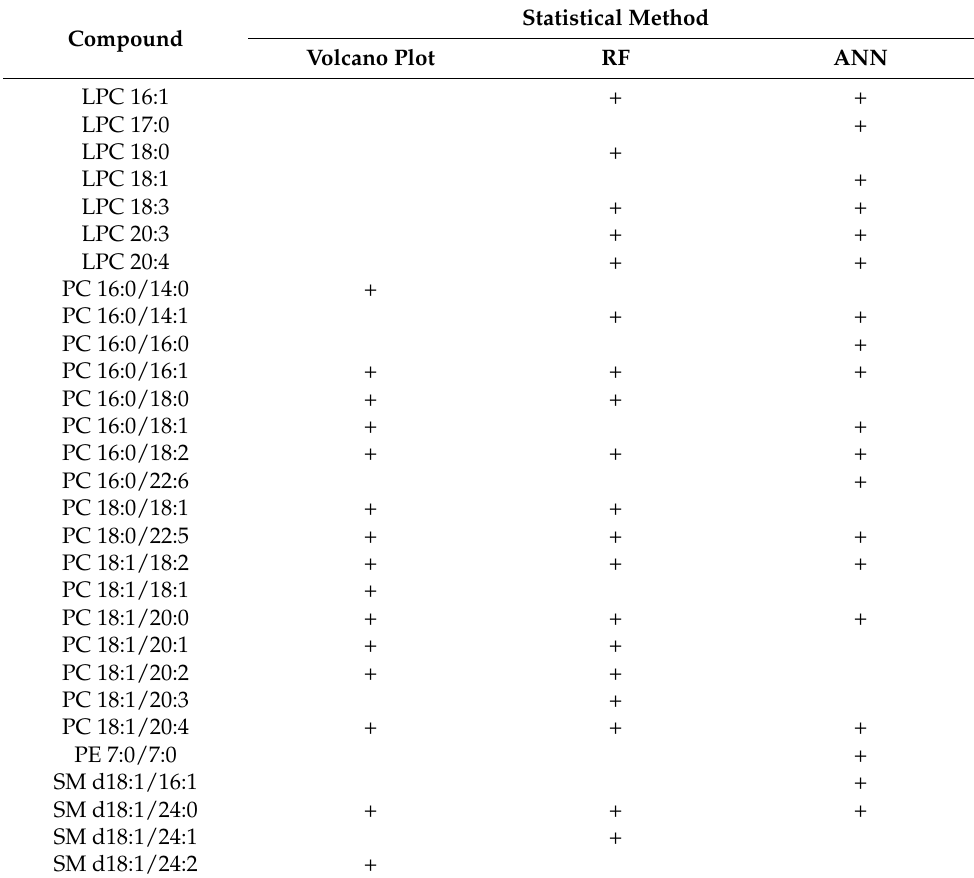
Table 3. Compounds assigned as metabolites with discriminant power determined using the ac- knowledge